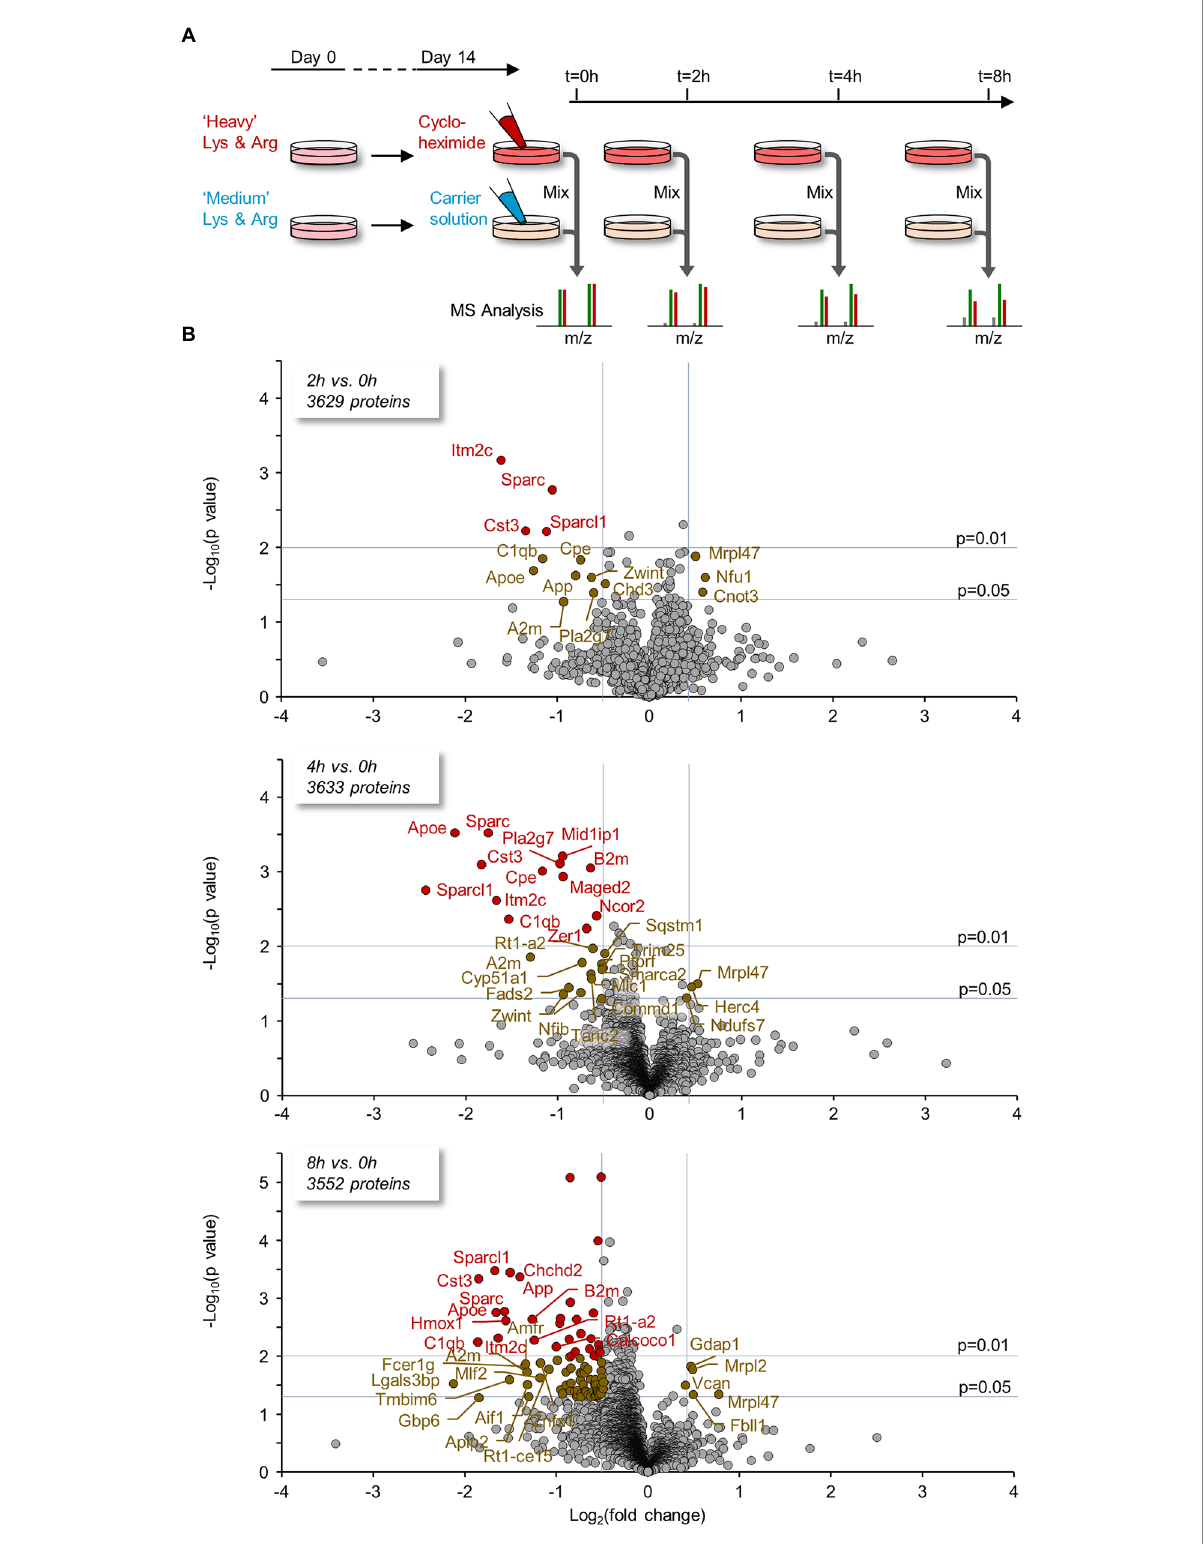
FIGURE 9 Proteins lost rapidly following protein synthesis suppression identified using SILAC and mass spectrometry. (A) Cortical neurons were grown for 14 days in media containing discernible, isotopically labeled amino acids (“Heavy” variants: Lys8 - 13 C 6 , 15 N 2 ; Arg10 - 13 C 6 , 15 N 4 , or “Medium” variants: Lys6 - 13 C 6 ; Arg6 - 13 C 6 ). At this point, CHX or a carrier solution was added; the cells were then harvested 0, 2, 4, or 8 hours after exposure. Time- matched pairs were mixed and the samples were analyzed by mass spectrometry (see Materials and Methods for details). For each protein at